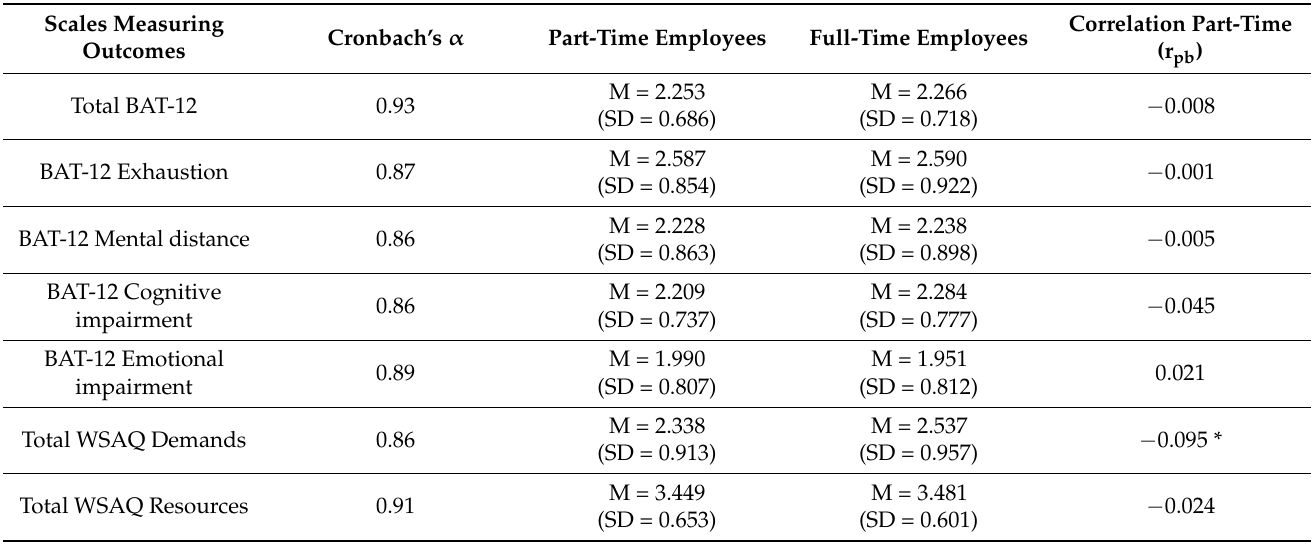
Table 2. Descriptive analysis of the independent variable (burnout risk) and mediating variables (job demands and